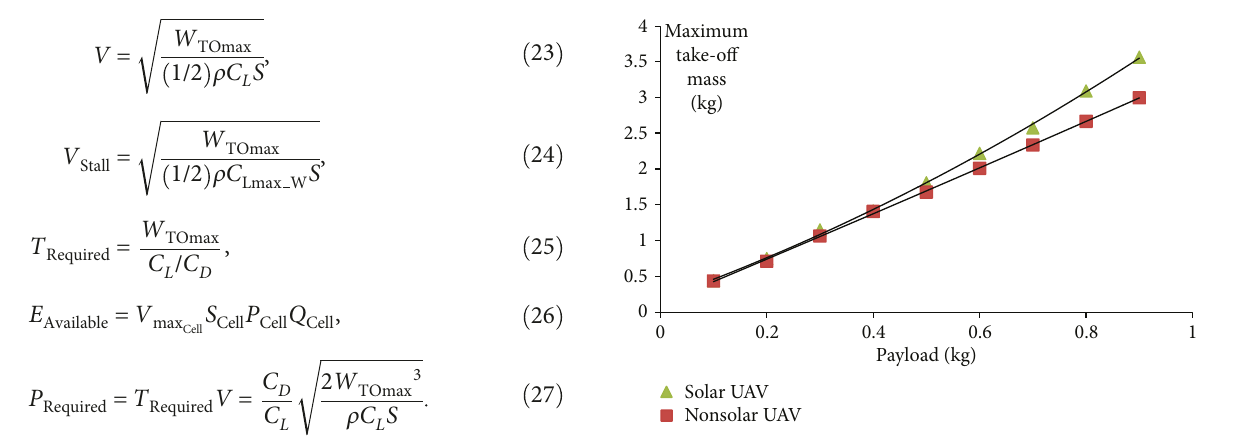
Figure 3: Payload versus maximum take-o ff mass of the solar and nonsolar